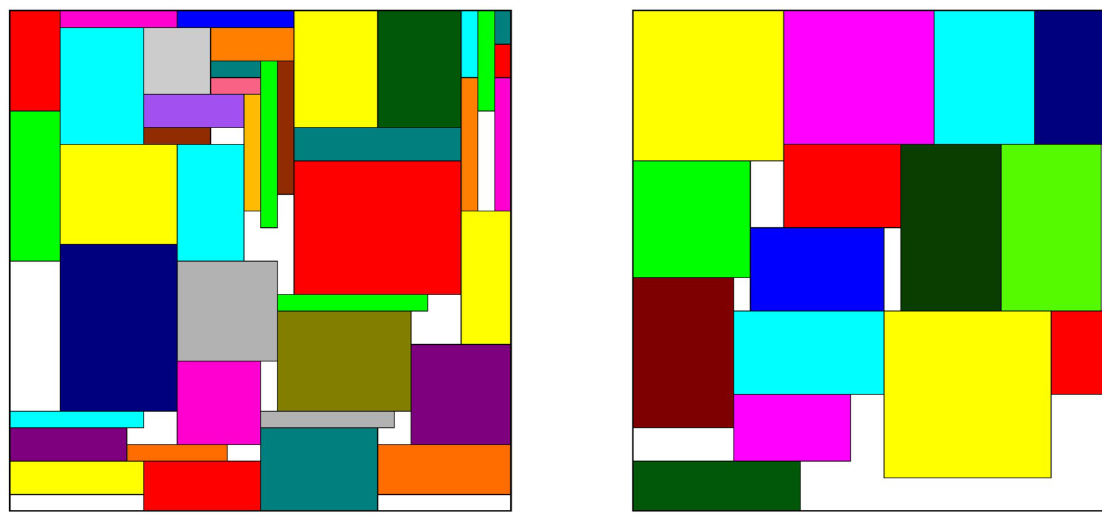
Fig 1. Example for 2D-BPP. Optimal configuration for an instance from [4] with two bins and more than 50 items.